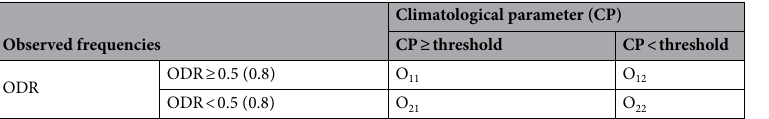
Table 2. Construction of contingency tables that meet the assumed conditions on ODR and climatological parameters.